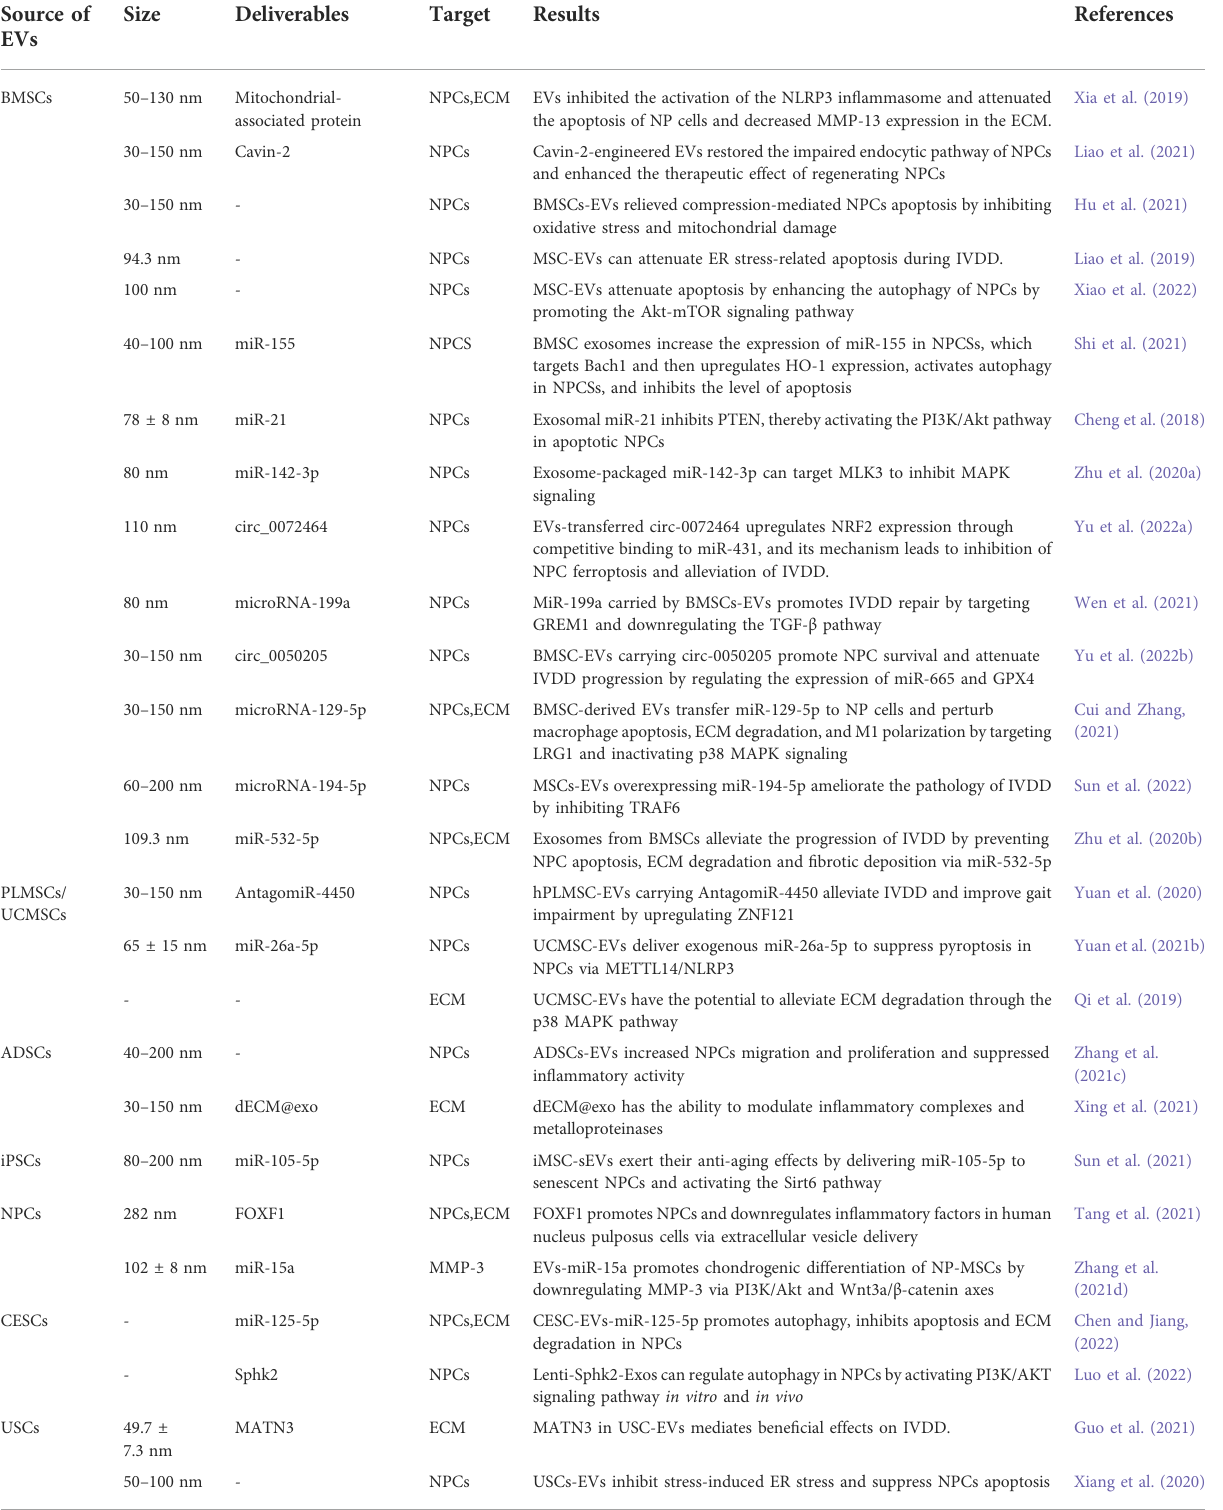
TABLE 1 Mesenchymal stem cell-derived extracellular vesicles in intervertebral disc